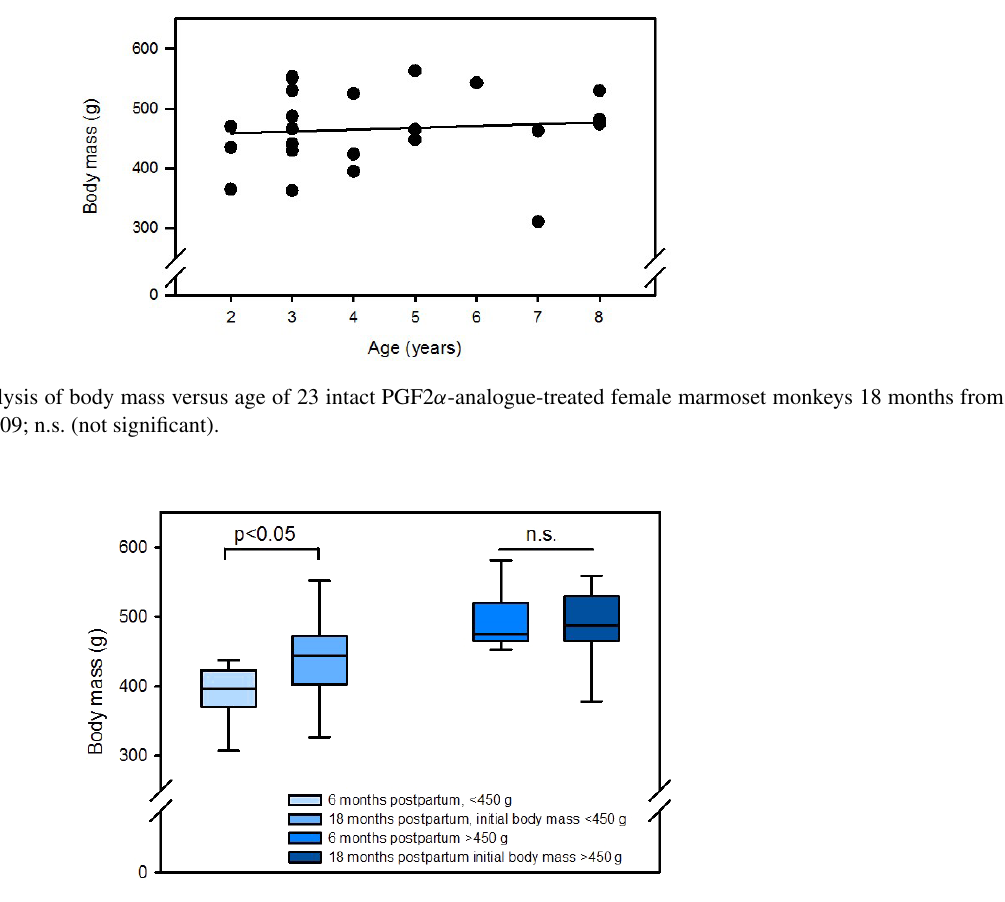
Figure A3. Body mass in 23 intact PGF2 α -analogue-treated female marmoset monkeys 6 and 18 months from the last parturition. Data from animals with initial body mass < 450g ( n = 12) or > 450g ( n = 11) are shown separately (Median, 5%, 25%, 75%, 95%